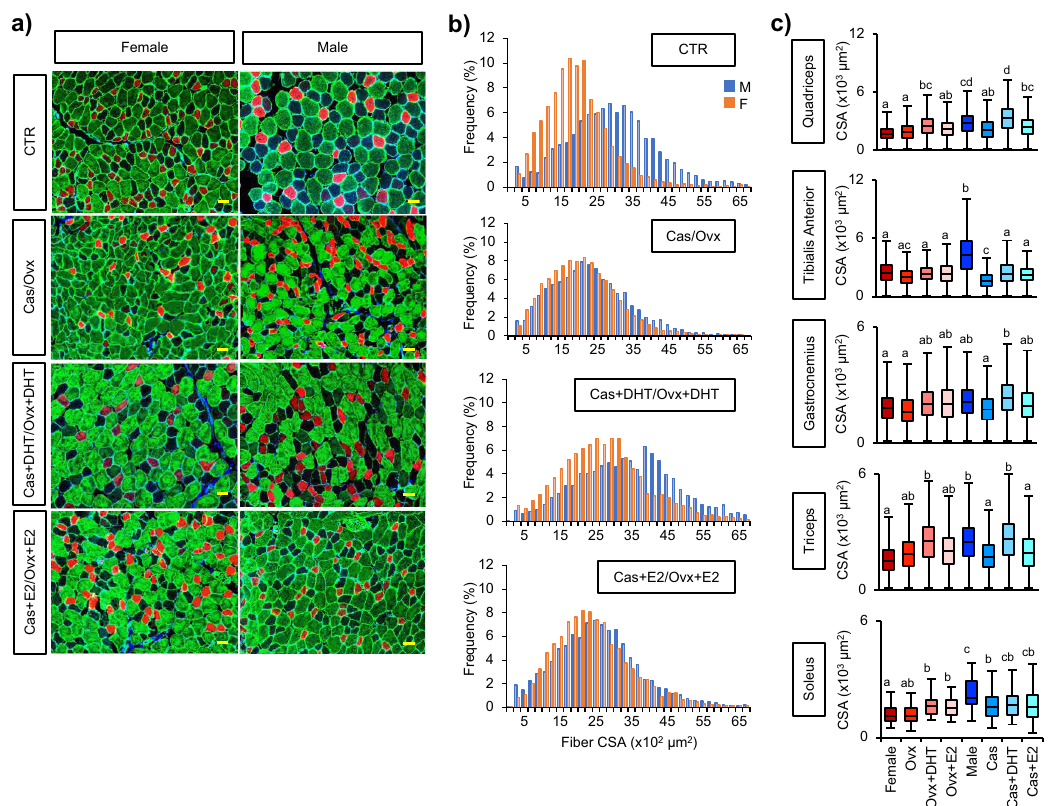
Fig. 1 Effects of sex steroids on skeletal muscle fi ber size. a Quadriceps muscle samples were prepared from eight experimental groups: sham-operated male and female mice (CTR), gonadectomized mice (Cas for males and Ovx for females), DHT-treated male mice (Cas + DHT), and female mice (Ovx + DHT) after gonadectomy, and E2-treated male mice (Cas + E2) and female mice (Ovx + E2) after gonadectomy (Supplementary Fig. 2). Type IIA (red) and type IIB (green) fi bers were detected with MYH2A and MYH2B antibodies, respectively. Blue: DAPI. Scale bar = 50 μ m. b The CSAs of the type IIB fi bers were measured using approximately 4800 to 6000 fi bers per specimen. The distributions of CSA sizes (horizontal axis) and frequencies (vertical axis) are shown. Male and female data are indicated by blue and orange bars, respectively. The same studies were performed using the tibialis anterior, gastrocnemius, triceps, and soleus muscles (Supplementary Fig. 1e). A representative result from three biologically independent samples is shown. c The CSA size distribution was compared among the eight experimental groups above. The data were analyzed as described in the “ Methods ” section. The box and whisker plots with the same letter are not signi fi cantly different from each other ( p <